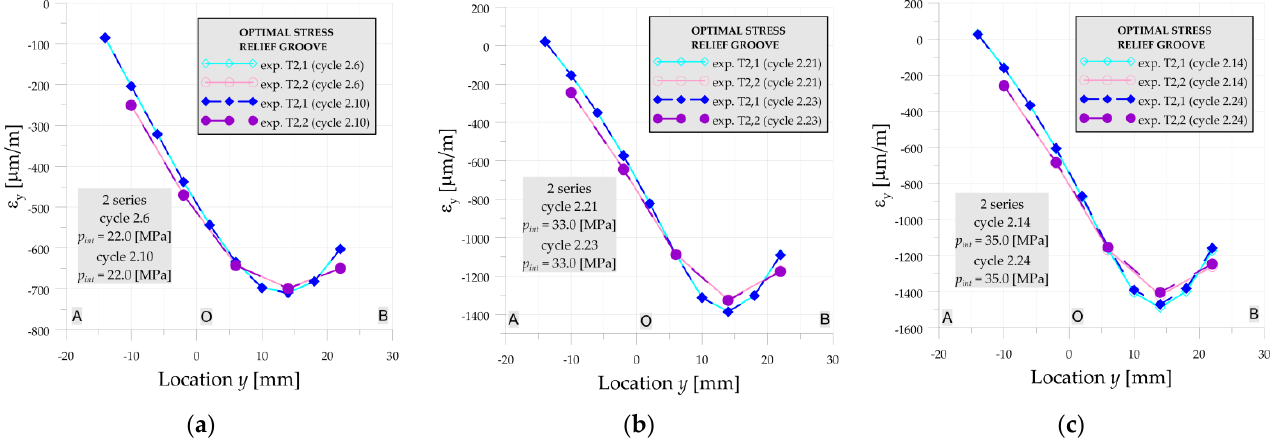
( c ) Figure A7. Repeatability of strain gauge measurements, non-optimal SRG, 1st series: ( a ) cycles 6 and 10; ( b ) cycles 21 and 23; ( c ) cycles 14 and 24. After 1st series, the pressure vessel has been annealed in order to eliminate residual stresses caused by the welding process and loading subjected in the 1st measurement se- ries. The location of the new strain gauge chains is given in Table 2. All measurements in